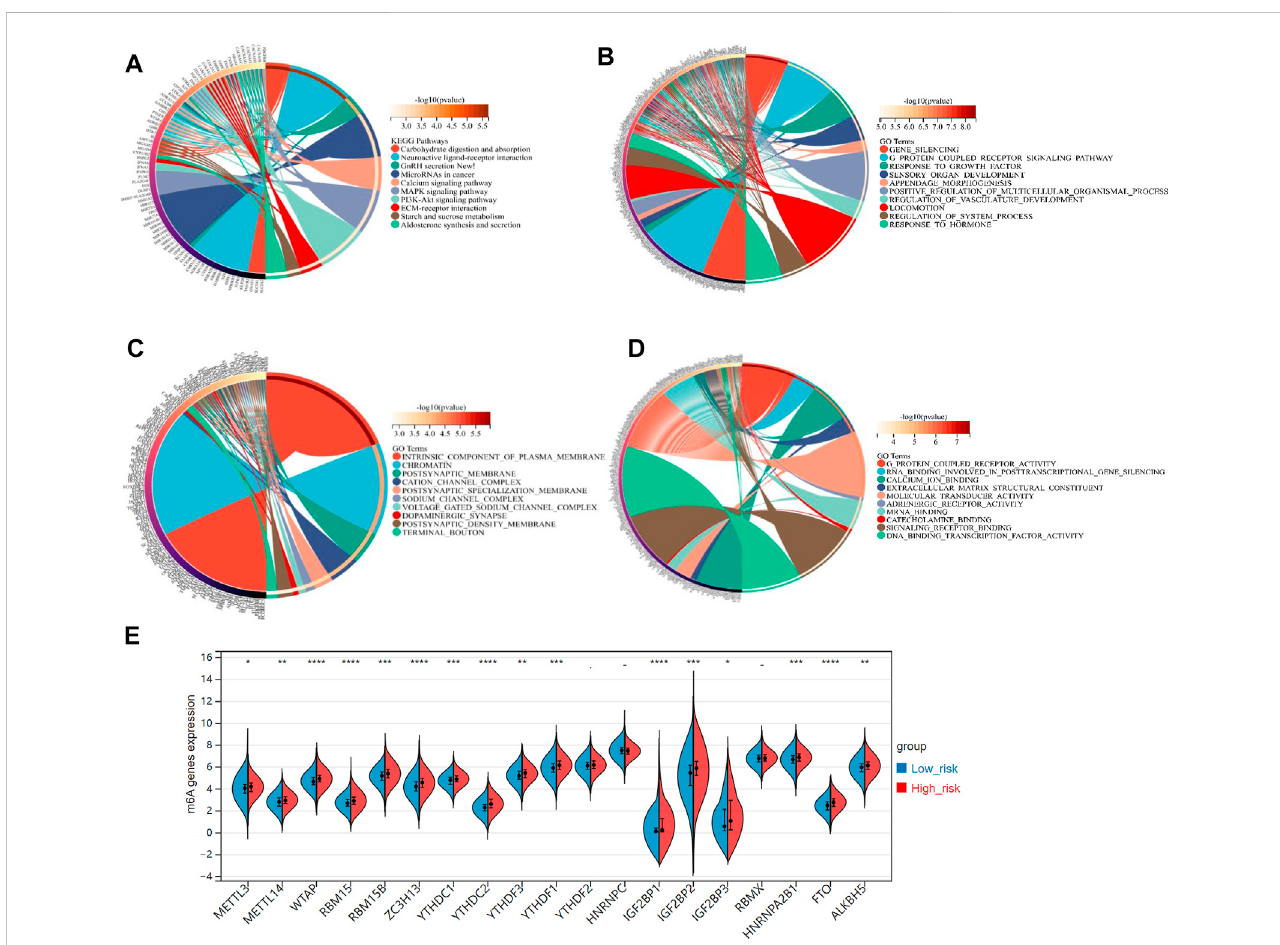
FIGURE 7 (A) The KEGG analysis of primary biological actions for potential mRNA. (B – D) The GO analysis of potential targets of mRNAs was also conducted in the aspects of biological process (BP), cellular component (CC), and molecular function (MF). The color scale represented p -value, and the size of the circles represented gene numbers. (E) The violin plot for the expression distribution of 19 m6A-related genes in low-risk and high-risk groups. * p -value < .05; ** p -value < .01; *** p -value < .001; **** p -value <